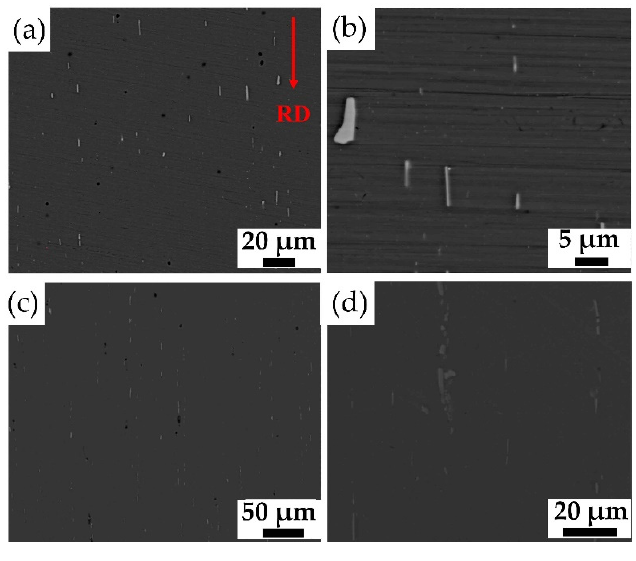
Figure 6. SEM micrographs of the solution treatment state of alloy 2195 at different multiples of ( a , b ) P1 and ( c , d ) P2. ( b , d ) are enlarged ones of ( a , c ).